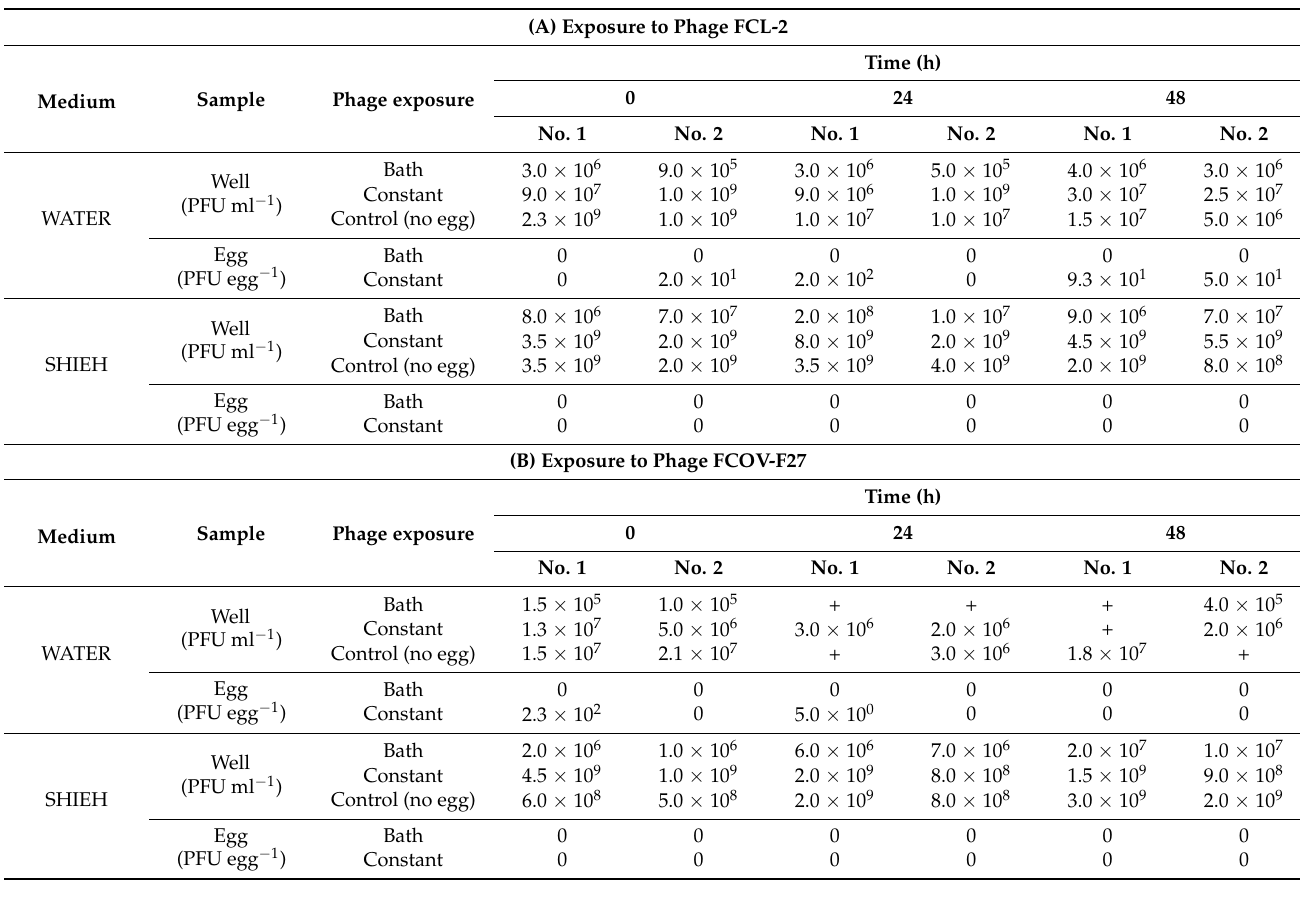
Table 3. Exp. III, section B: F. columnare infecting phage titers in eggs and the surrounding medium (water or Shieh medium) at 0, 24, and 48 h. Phage counts for two individual samples are provided for each treatment. A “+” indicates a positive detection of